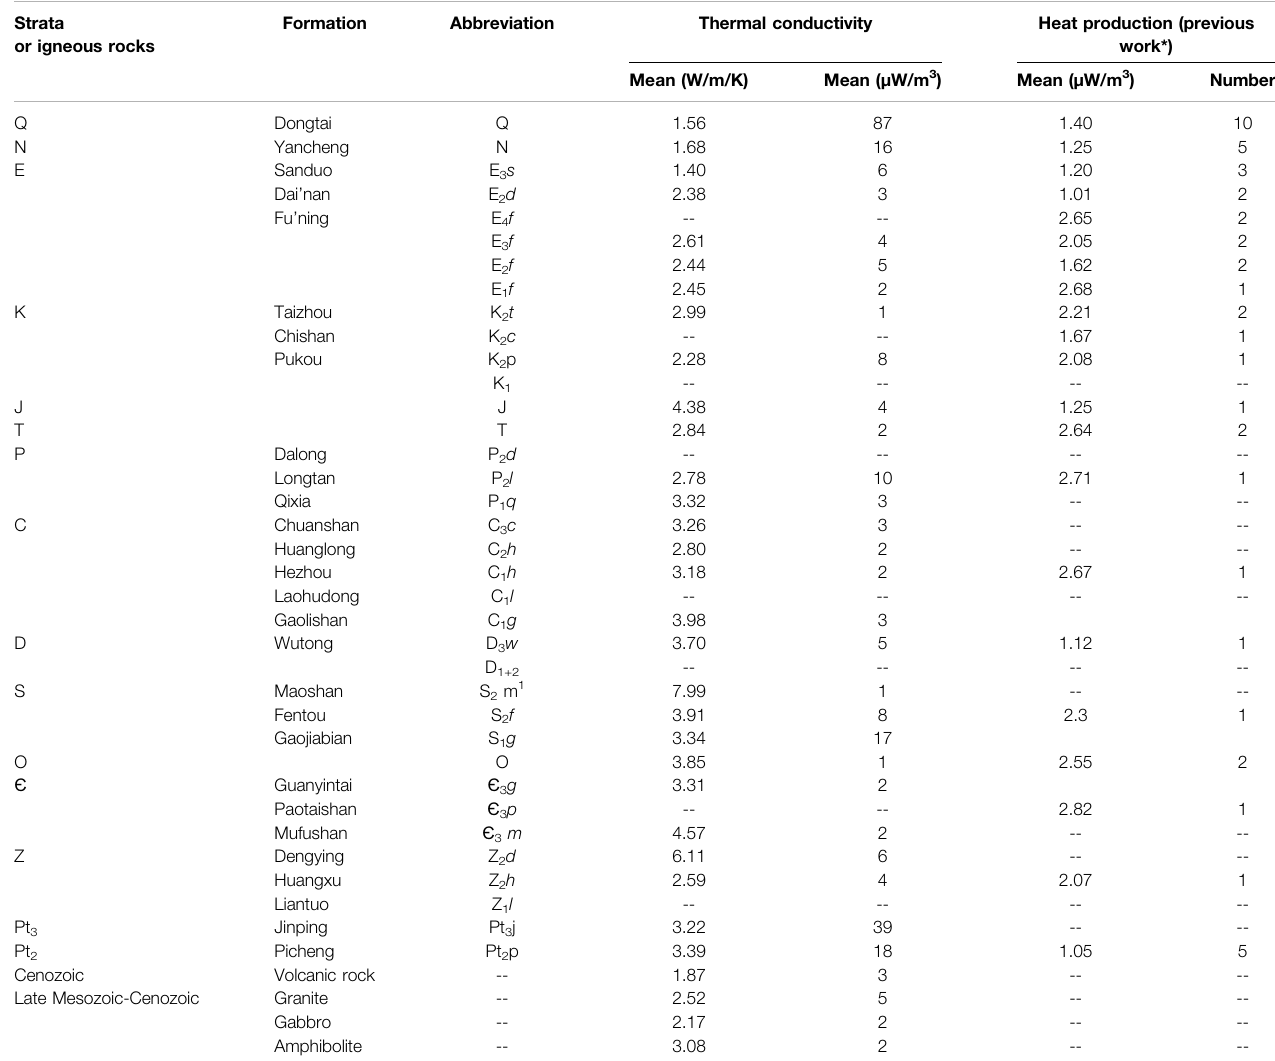
TABLE 2 | Thermal conductivity and heat production of different rock types in the North Jiangsu Basin. Strata or igneous rocks